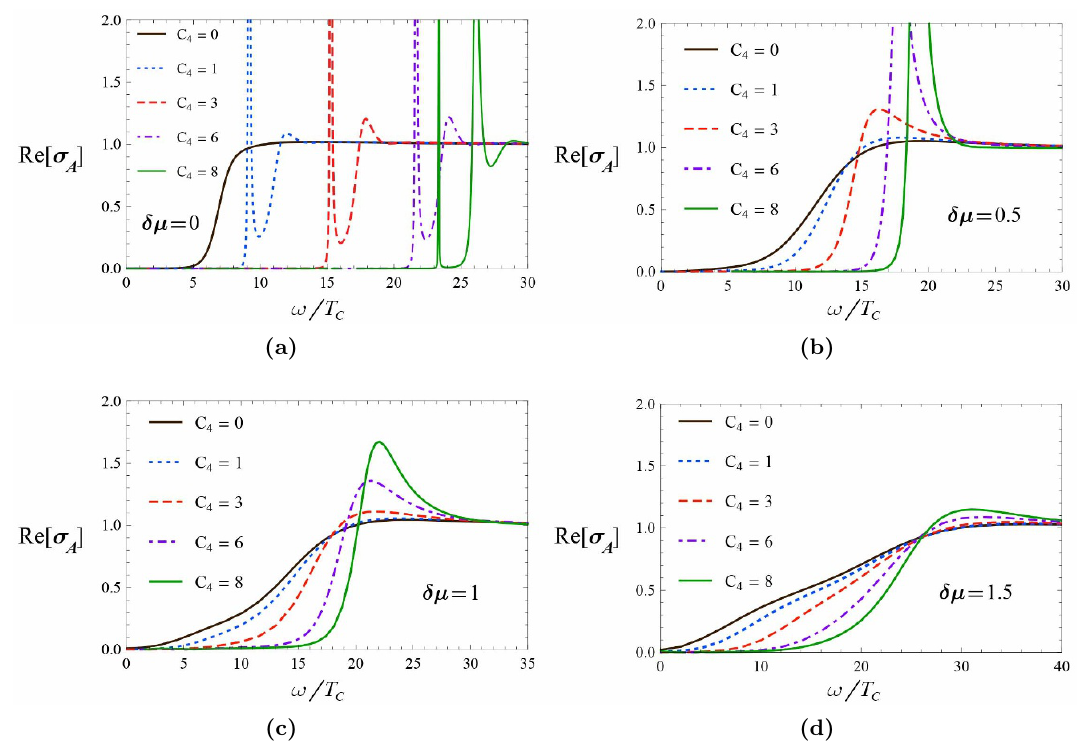
Figure 11. The real part of the mixed conductivity in terms of !=T c for function F ( ) = 2 + C 4 4 with C 4 = 0 ; 1 ; 3 ; 6 ; 8 (solid curve, dotted curve, dashed curve, dot-dashed curve, and pale (green) solid curve) and (cid:14)(cid:22) = 0 ; 0 : 5 ; 1 ; 1 : 5 ((cid:12)gures (a), (b), (c), and